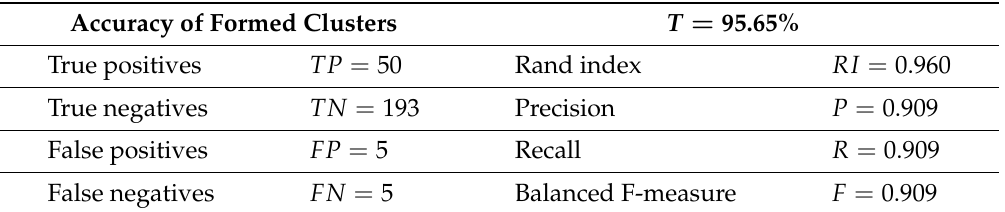
Table 5. Evaluation of clustering results obtained by IBC2 algorithm using CMU-MMAC database.